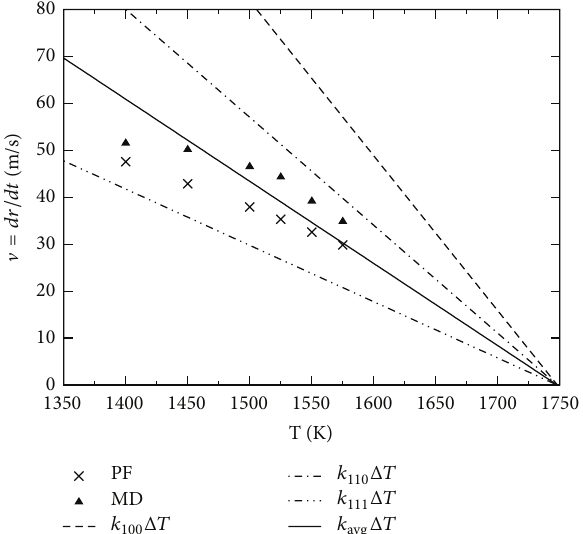
Figure 7: Sphericity of the crystal for different undercoolings. The contour shows the shape of the [100] cutting plane through the center of the crystal for 𝑇 = 1400 K and 1550